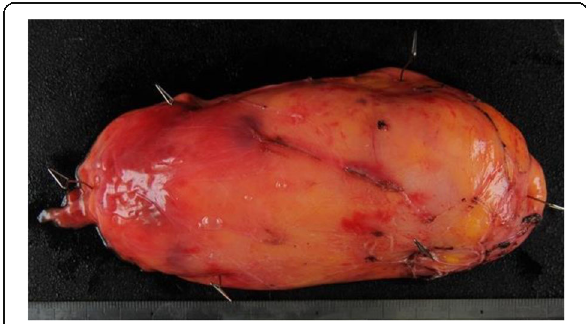
Fig. 3 Histopathological examination. The yellow and soft giant lipoma, measuring 14.0 × 6.5 × 3.0 cm in size with diffuse mature